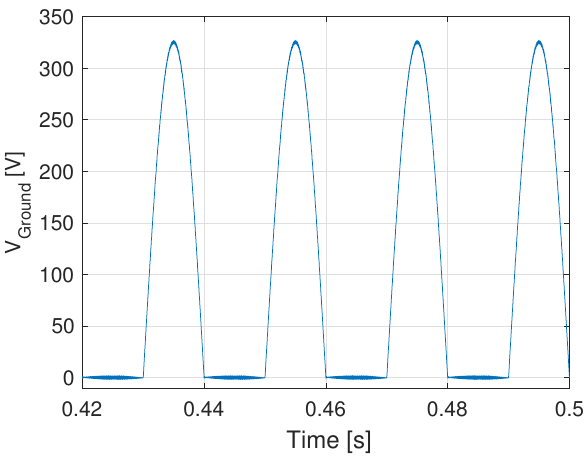
Figure 10. CSI5 topology v ground waveform with zero C PV .